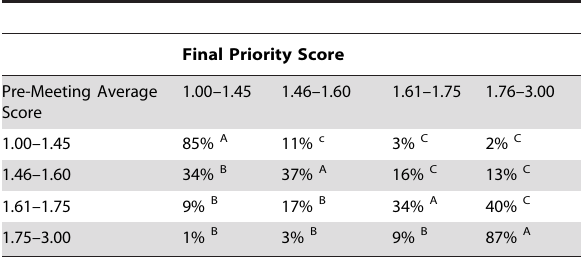
Table 3. Change between Average Preliminary Score and Final Priority